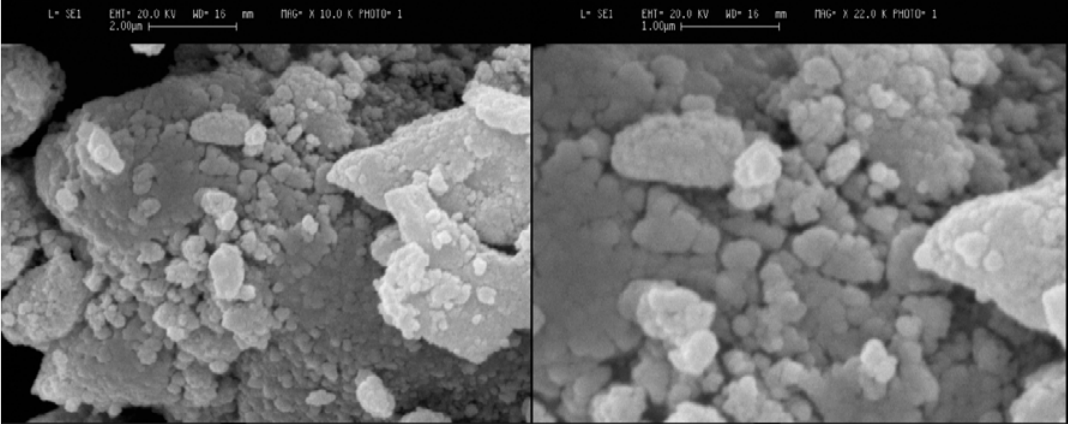
Fig. 3. SEM image of the